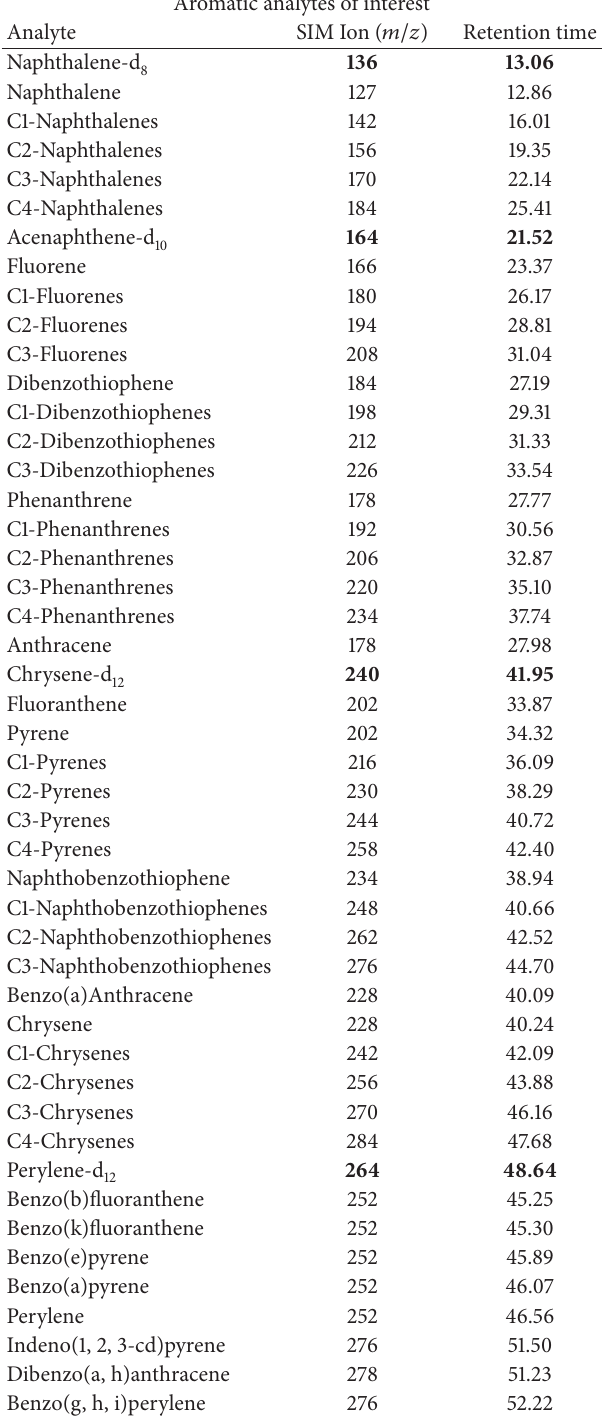
Table 1: Analytes of interest and their alkylated counterparts as identified by the Selective Ion Monitoring method developed for the identification of crude oil used to analyze menhaden